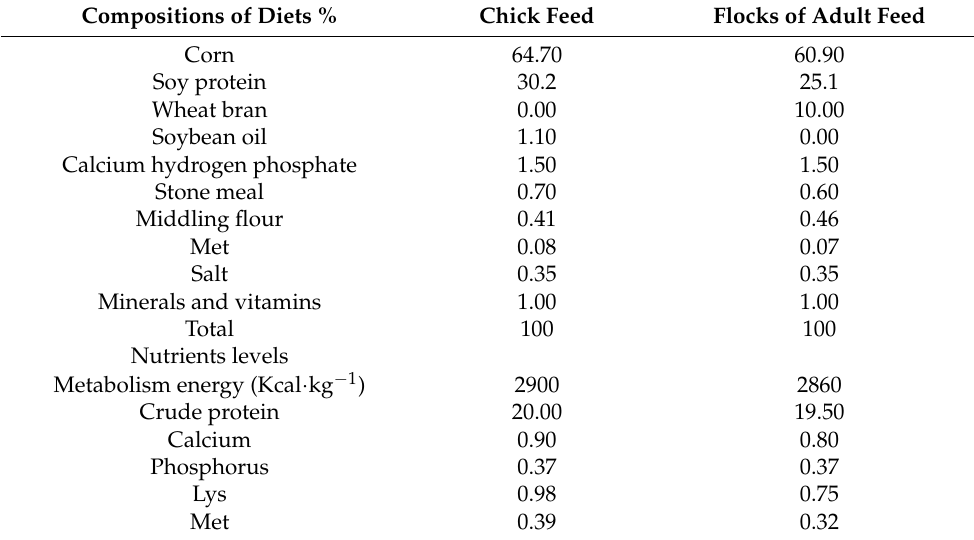
Table 1. Diet composition and nutrition level.